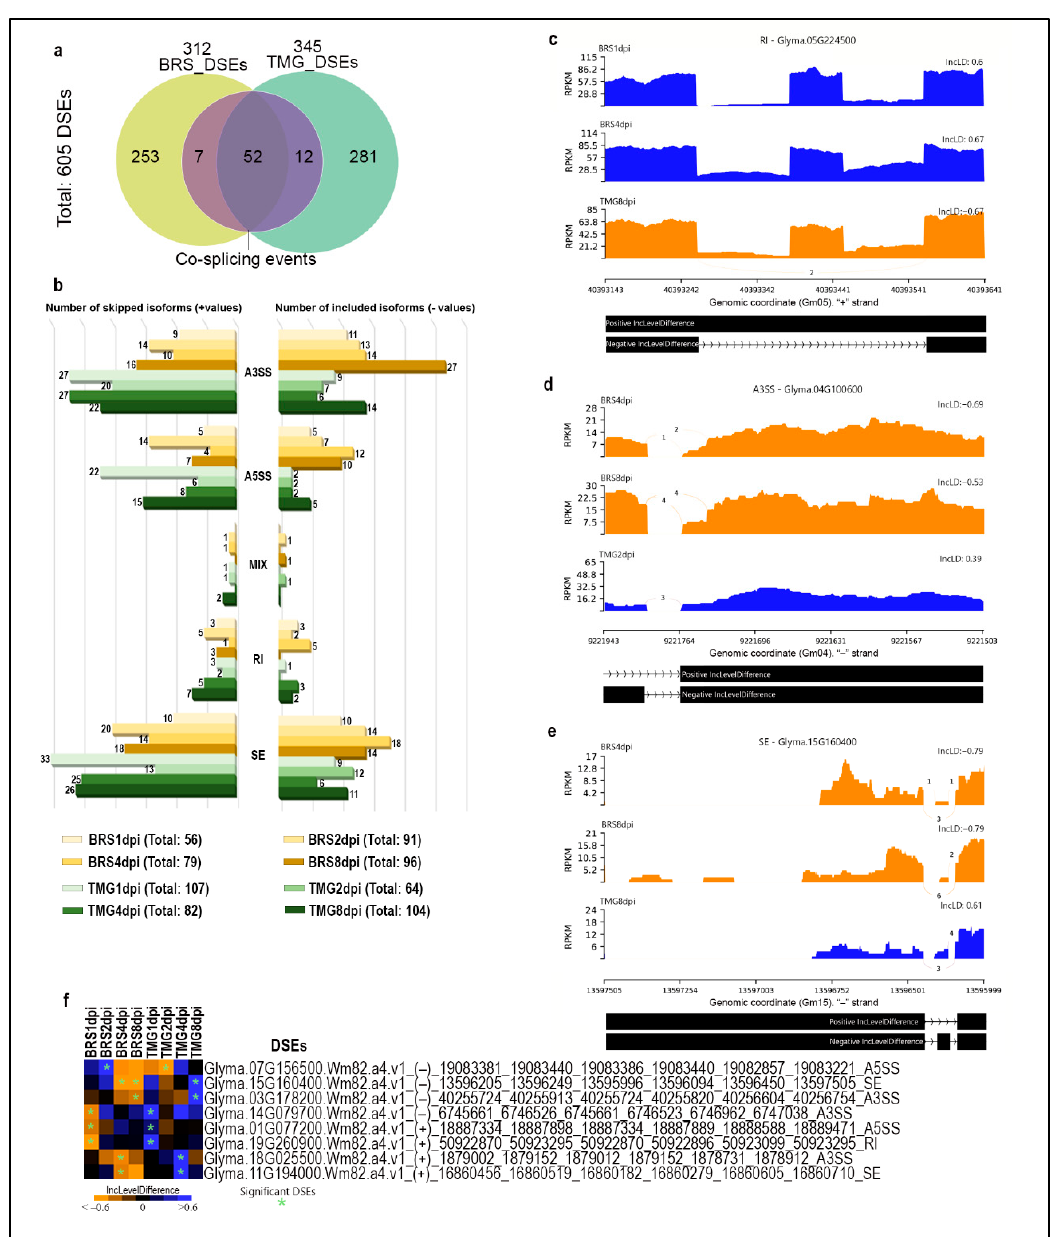
Figure 4. Soybean alternative splicing events landscapes in response to RLN. Venn diagram showing unique and shared differentially splicing events (DSEs) in BRS and TMG under RLN infection ( a ). Numbers of skipping and inclusion isoforms of splicing events in BRS and TMG in response to RLN at 1, 2, 4, and 8 dpi ( b ). Sashimi-plot of differential splicing of retained intron ( c ), 3 (cid:48) untranslated regions ( d ), and skipped exons( e ). Heatmap showing the impact of RLN infection on 8 DSEs that presented inverted profiles between genotypes ( f